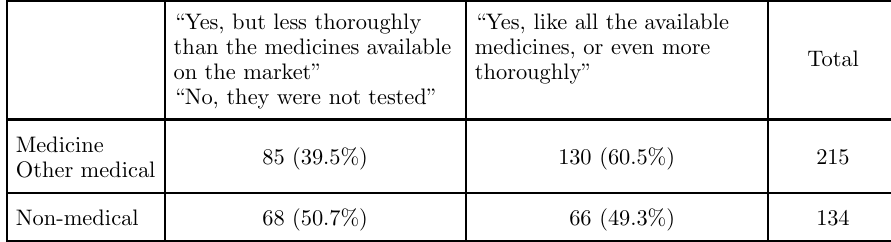
Table 3. Correspondence between faculty and opinion concerning studies on vaccines “Yes, but less thoroughly “Yes, like all the available than the medicines available medicines, or even more on the market” thoroughly” “No, they were not tested” Medicine 85 (39.5%) 130 (60.5%) 215 Other medical Non-medical 68 (50.7%) 66 (49.3%)